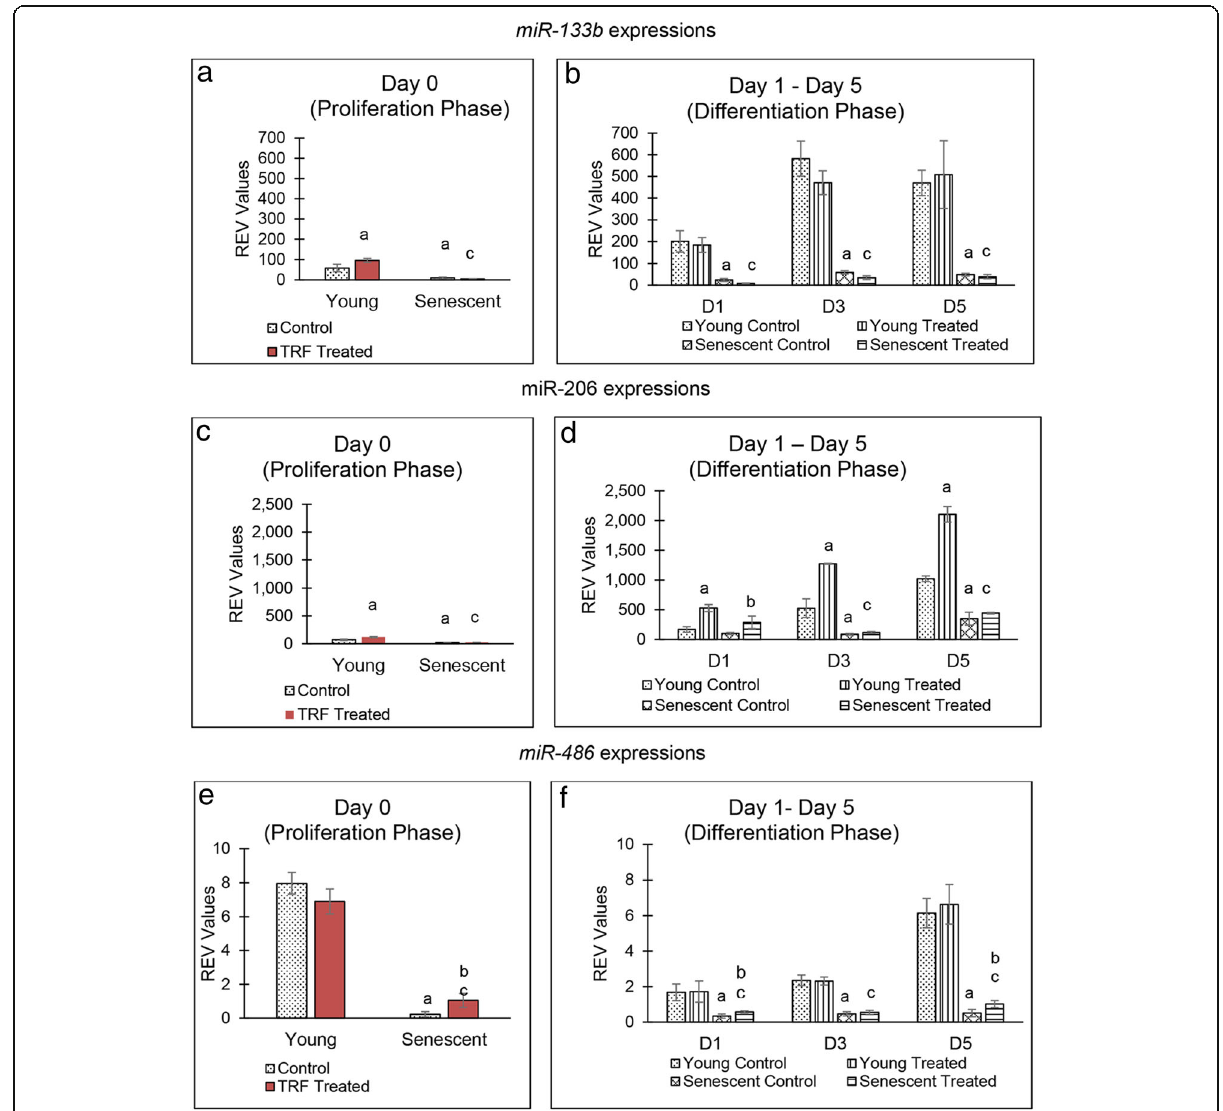
Fig. 4 Effect of TRF on the expression of micro RNAs during proliferation and differentiation of young and senescent myoblasts. Expression of miR-133b ( a , b ), miR-206 ( c , d ) and miR-486 ( e , f ) in young control myoblasts, TRF-treated young myoblasts, senescent control myoblasts and TRF- treated senescent myoblasts. a Denotes p < 0.05 compared to young control, b p < 0.05 compared to senescent control and c p < 0.05 compared to young TRF-treated myoblasts. Data are presented as relative expression value (REV) normalised to RNU6B expression (mean ± SD, n =